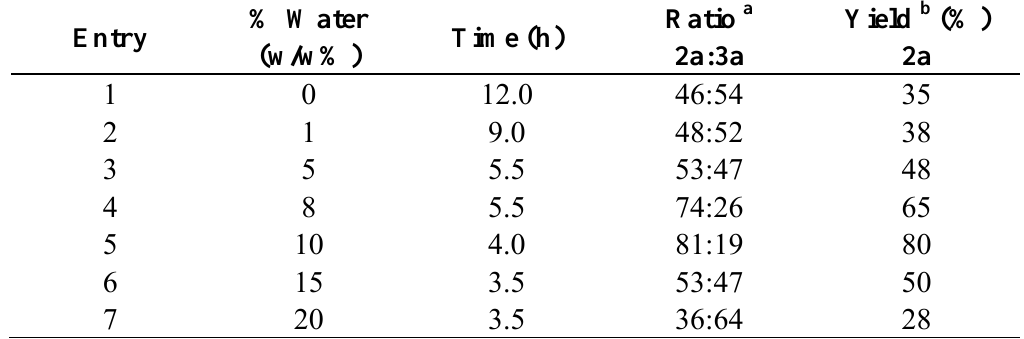
Table 2. The effect of water-ethanol percentages on the monohydrolysis of 1a using 1.2 equivalents of